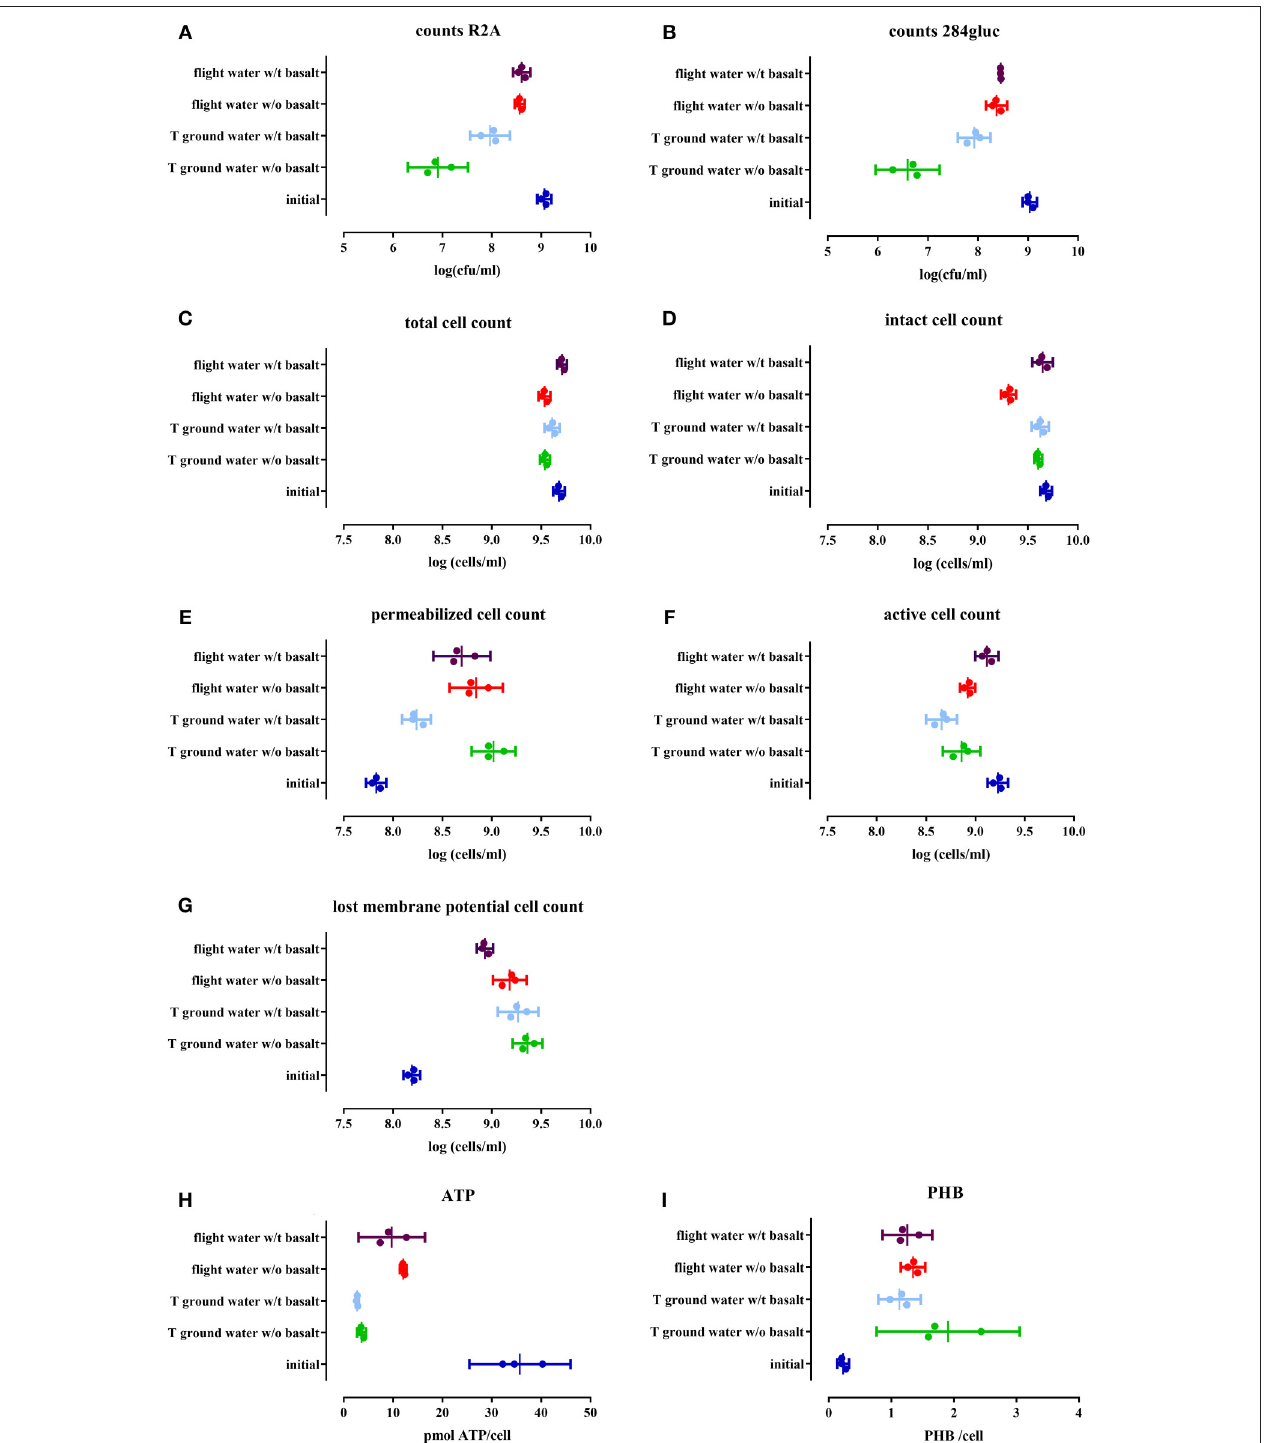
FIGURE 2 | Cell physiology, cultivability, ATP and PHB levels of an initial stationary phase culture of CH34 cells stored in mineral water with (indicated with w/t) and without (w/o) basalt, analyzed after the three month flight experiment and after the control temperature ground experiment. All replicates are represented by a dot; the mean is indicated as a line as well as the 95% confidence interval between the brackets. For the statistical analysis, one way ANOVA was used with Tukey post testing (alpha = 0.05), p -values as well as significance are reported in Table 4 and in Supplementary Table S2 . Samples were plated on R2A (A) and 284MM (B) to determine cultivability of CH34. The total cells number (SG) (C) as well as the number of intact cells (SGPI) (D) , permeabilizated (SGPI) (E) , active (cFDA) (F) , and cells which have lost their membrane potential [DIBAC 4 (3)] (G) were measured. ATP (H) and PHB (I) content of the cells was also measured.